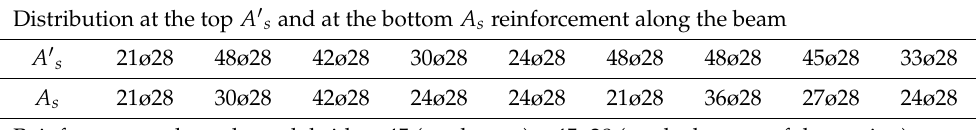
Figure 2. Bridge over the Corace River: ( a ) Dimensions of the arch bridge and ( b ) details of the current section of the beam, of the arch bridge and of the columns (measures expressed in meters). Table 1. Distribution of the steel reinforcement in the beam, in the arch and in the columns (the upper, (cid:1827) (cid:3046) (cid:4593) , and downer, (cid:1827) (cid:3046) , steel area is expressed in a number of steel bars per diameter—for instance, 21 bars of 28 mm of diameter: 21ø28). Distribution of the Steel Reinforcement in the Structural Elements Distribution at the top (cid:1827)′ (cid:3046) and at the bottom (cid:1827) (cid:3046) reinforcement along the beam